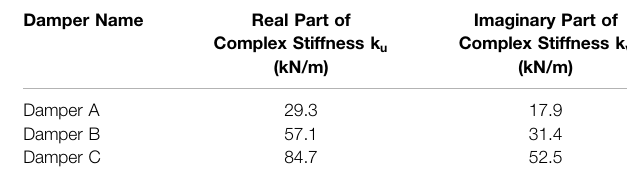
TABLE 7 | Damper parameters in experimental veri fi